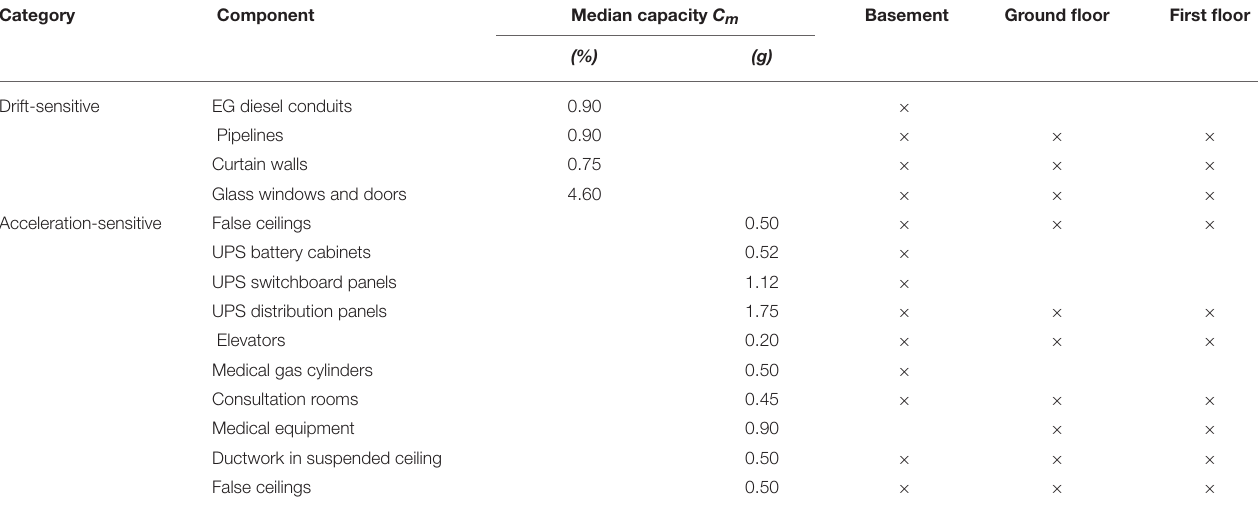
TABLE 1 | Floor distribution of non-structural components (NSCs) and pieces of technological content